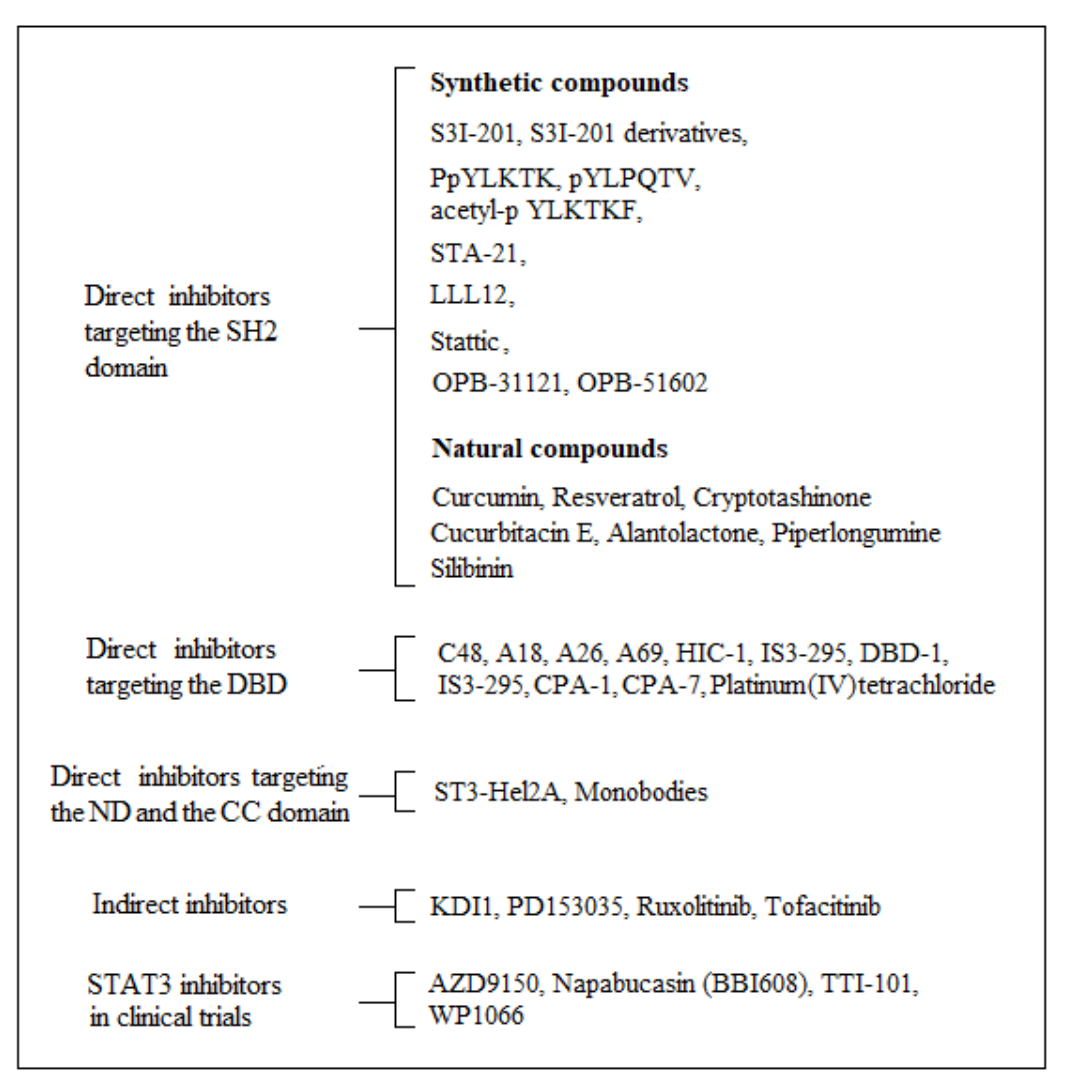
Figure 3. STAT3 inhibitors.